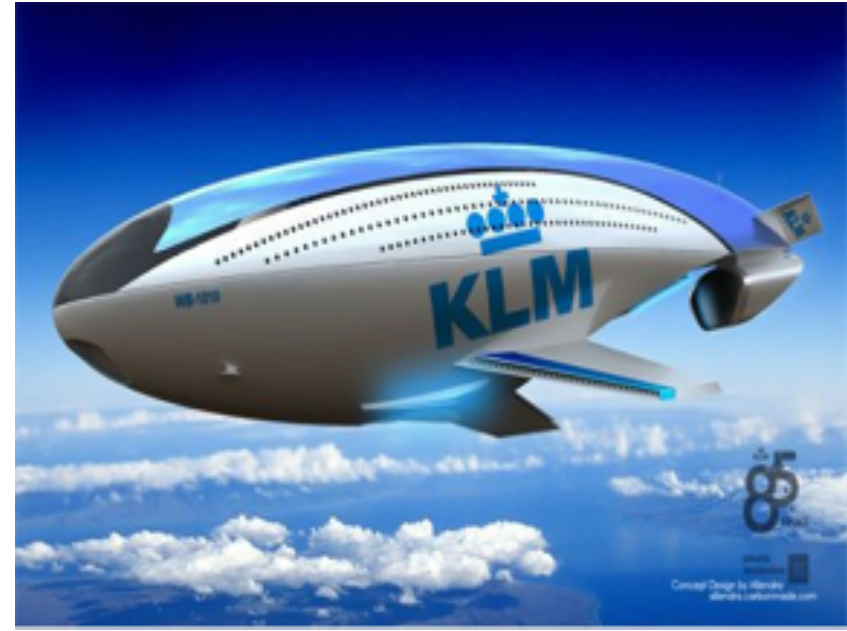
Figure 4. WB-1010 (Adapted from Ref. [41]).